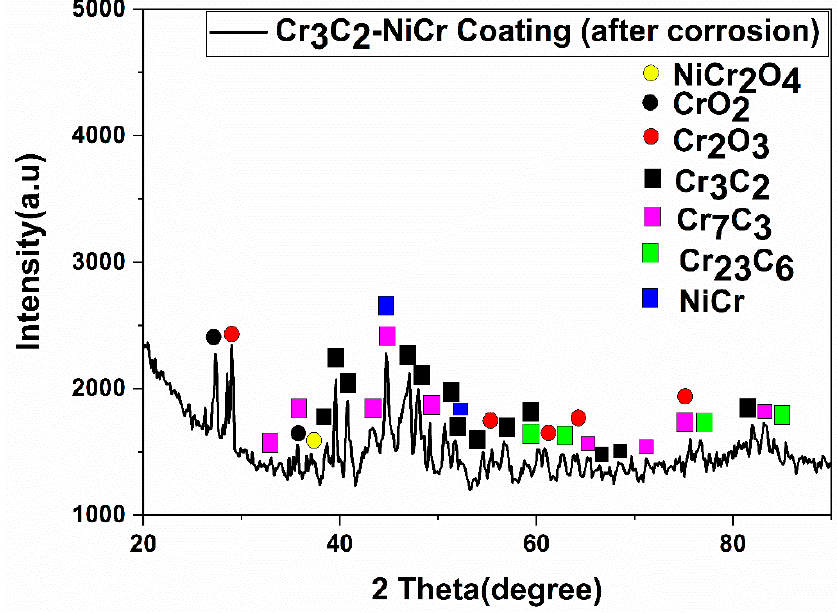
ff raction pattern of the Cr 3 C 2 –NiCr-coated sample after Figure 11. X ‐ ray diffraction pattern of the Cr 3 C 2 –NiCr ‐ coated sample after erosion ‐ corrosion. Figure 11. X-ray di